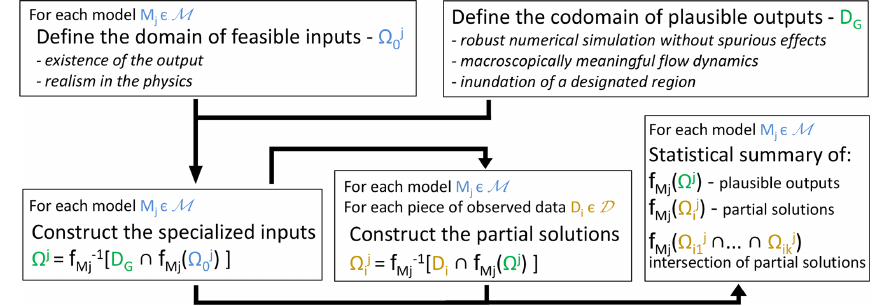
Figure 6. Diagram of the steps of our meta-modeling approach. Our statistical summary includes the local analysis of contributing variables.